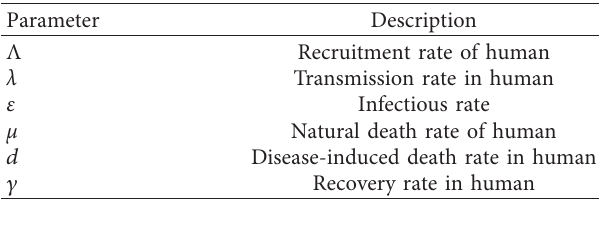
Table 1: Description of parameters used in the model.